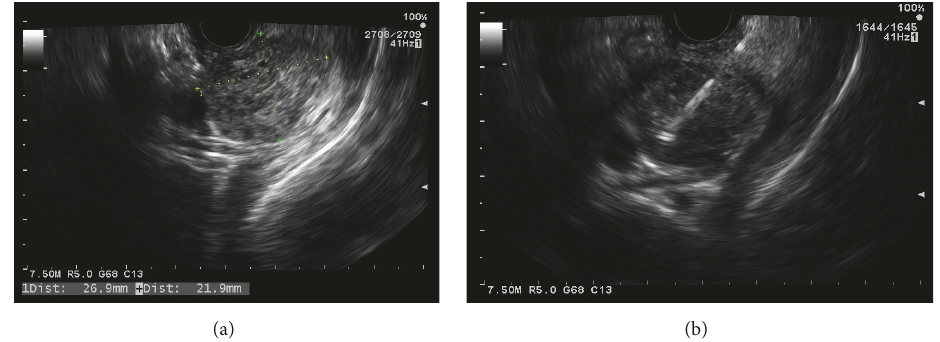
Figure 1: (a) EUS examination of the thyroid revealed a hypoechoic, round, and well-demarcated mass that measured 26.9 mm × 21.9 mm in the right lobe. (b) Under echoendosonographic guidance, FNA with a 25-gauge needle (Expect EUS-FNA 25 G needle; Boston Scientific, Menomonie, WI, USA) was performed